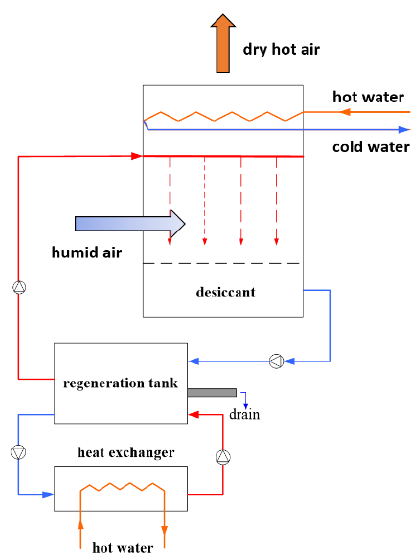
Figure A4. Schematic of LDD